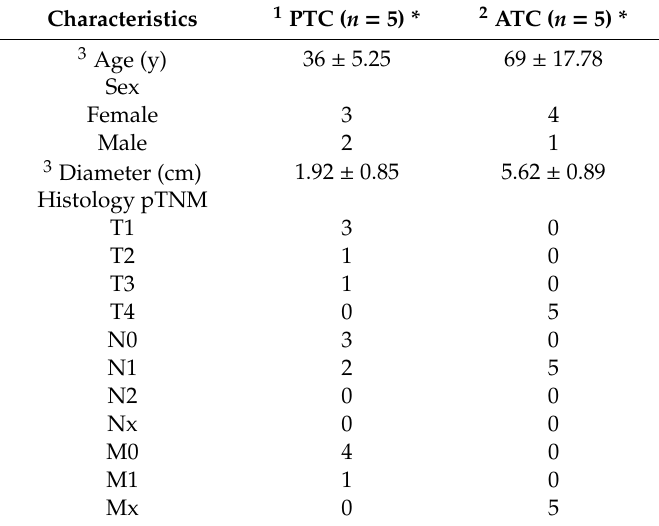
Table 1. Patients’